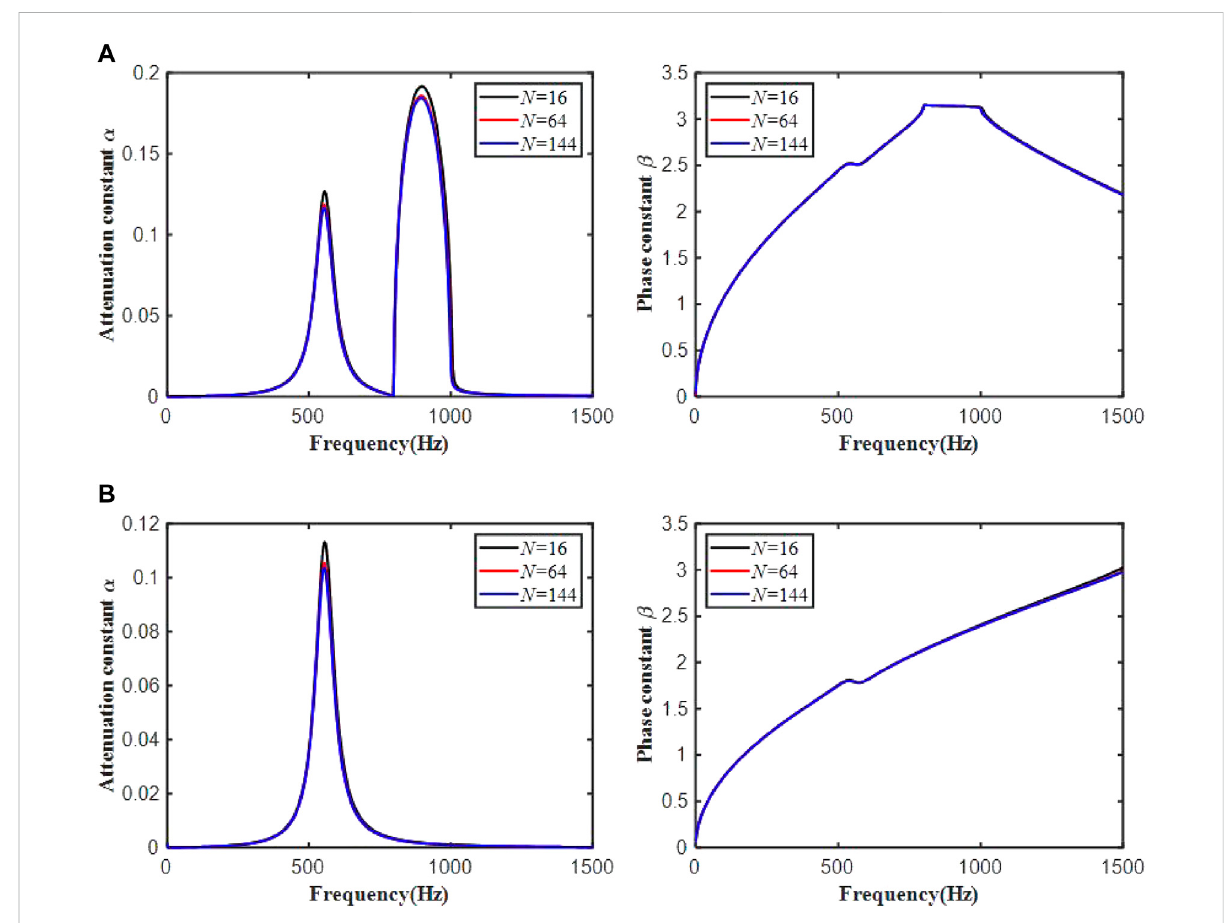
FIGURE 3 Convergence of propagation constants with different amount of elements: (A) tan( θ ) = 0.2; (B) tan( θ ) =